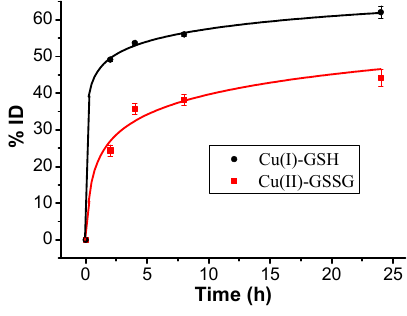
Figure 4. Copper contents in the urine of BALB/c ( n = 3) at different times post injection (p.i.).